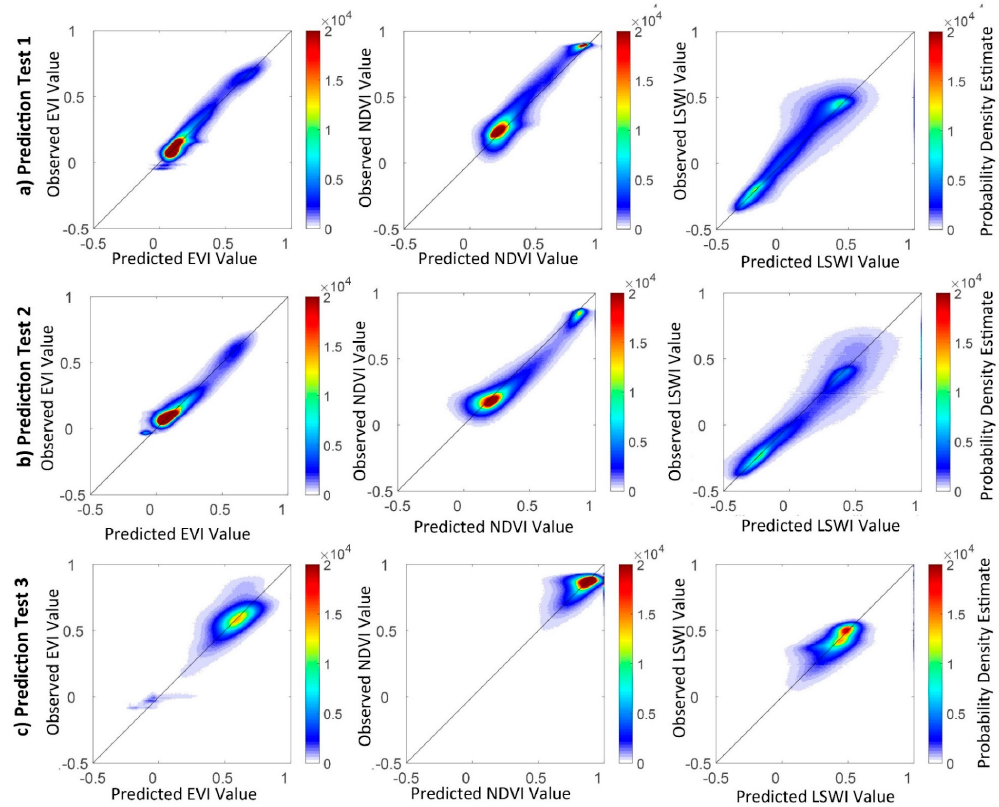
Figure 11. Scatter density plots of the real VIs and the predicted ones by the STARFM in ( a ) Prediction Test 1, ( b ) Prediction Test 2, ( c ) Prediction Test 3.